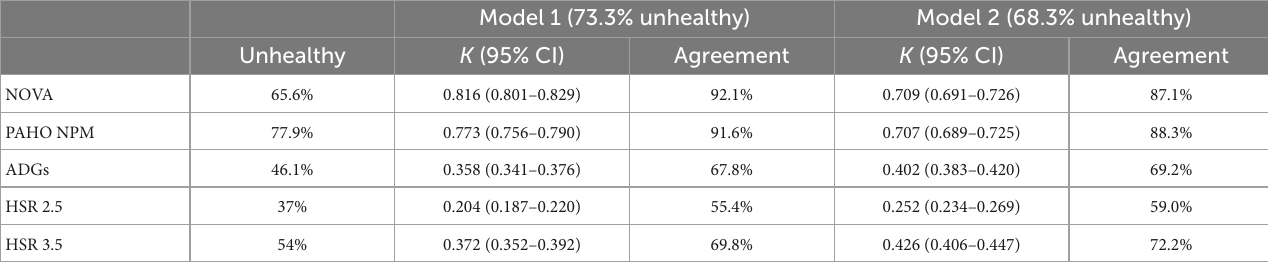
TABLE 6 Pairwise agreement between Model 1 and Model 2, and NOVA, PAHO NPM, the ADGs, and the HSR using Cohen’s Kappa co-efficient and percentage